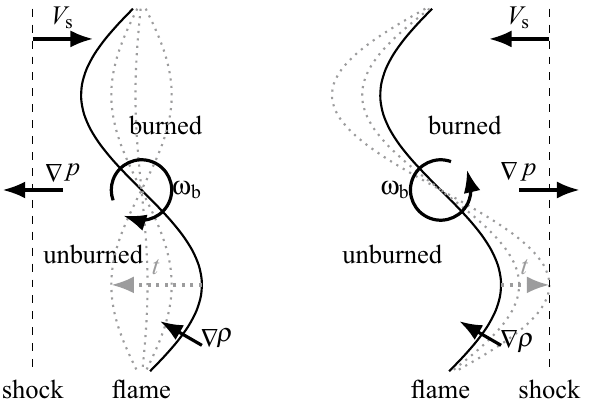
Figure 1. Schematic of the Richtmyer–Meshkov mechanism. Left: Shock wave propagating at speed V s from unburned to burned gas, causing the phase reversal effect. Right: Shock wave propagating from burned to unburned gas, amplifying the initial